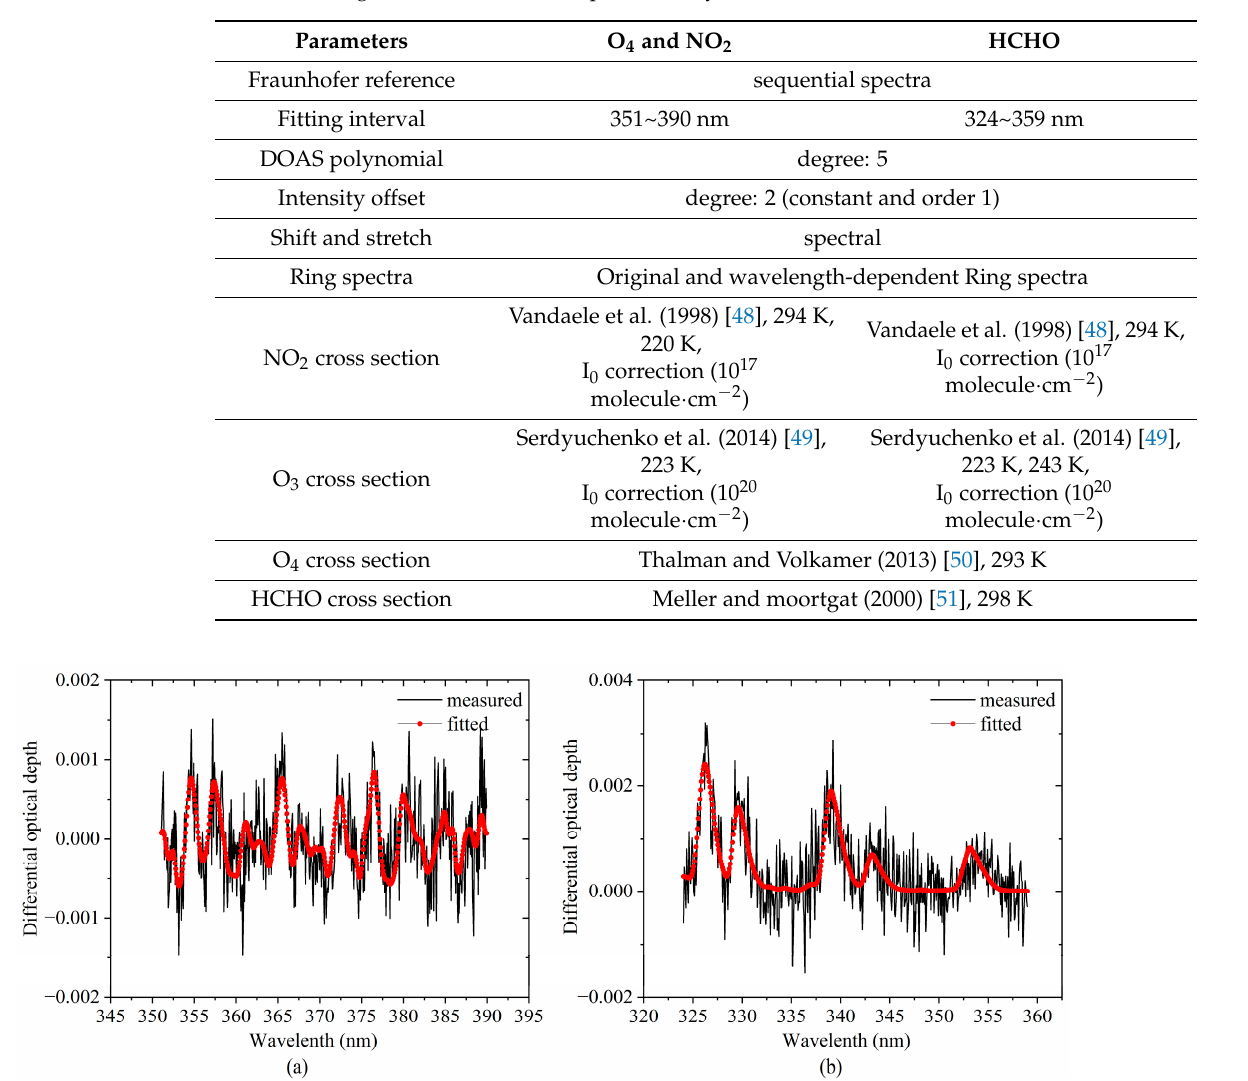
Table 1. Setting for NO 2 and HCHO spectral analyses.